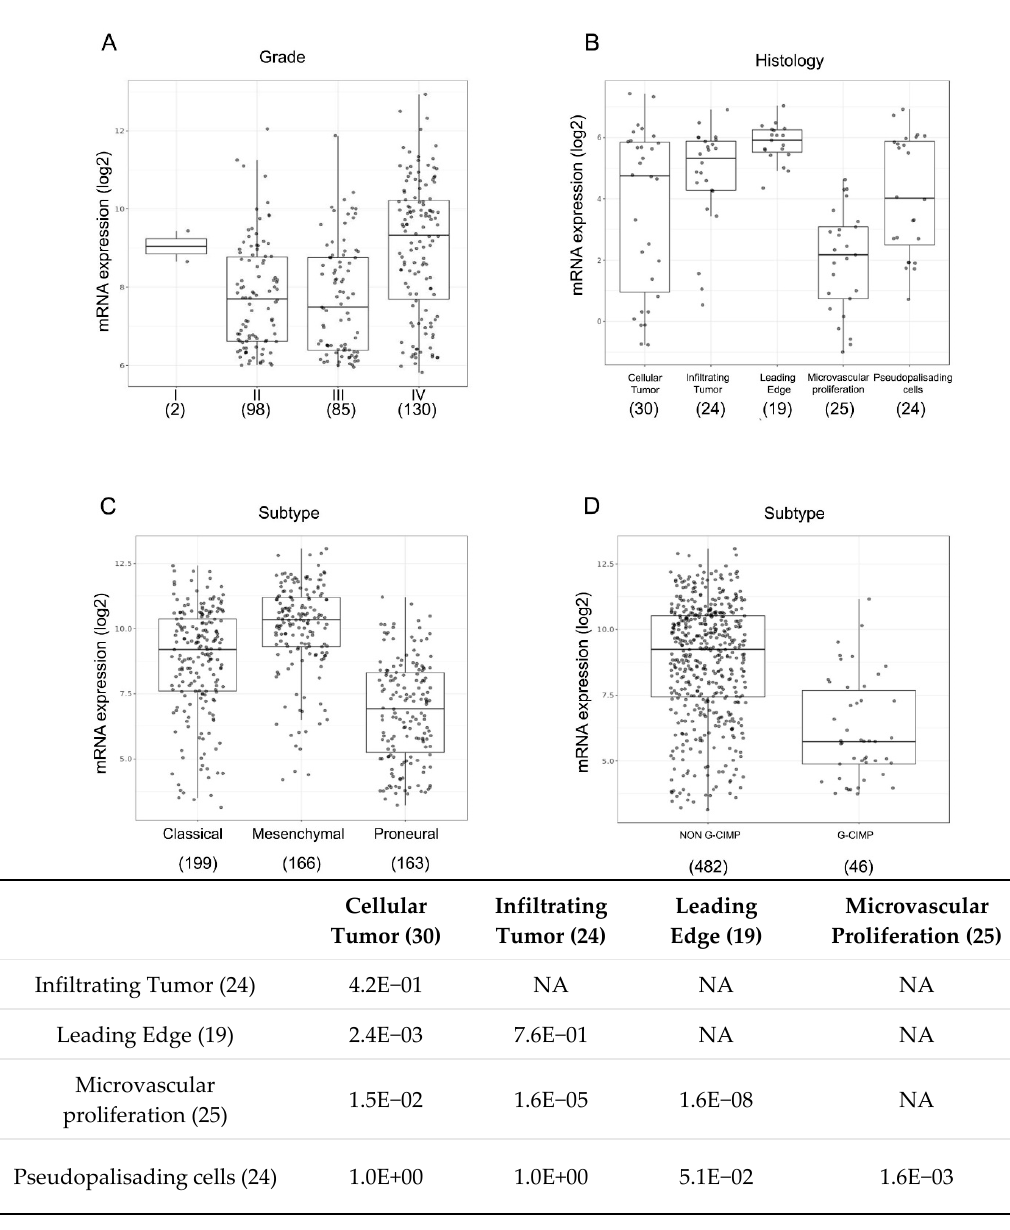
Figure 7. CXCL14 expression correlates with aggressive features in glioblastoma. ( A ) Box-plots of